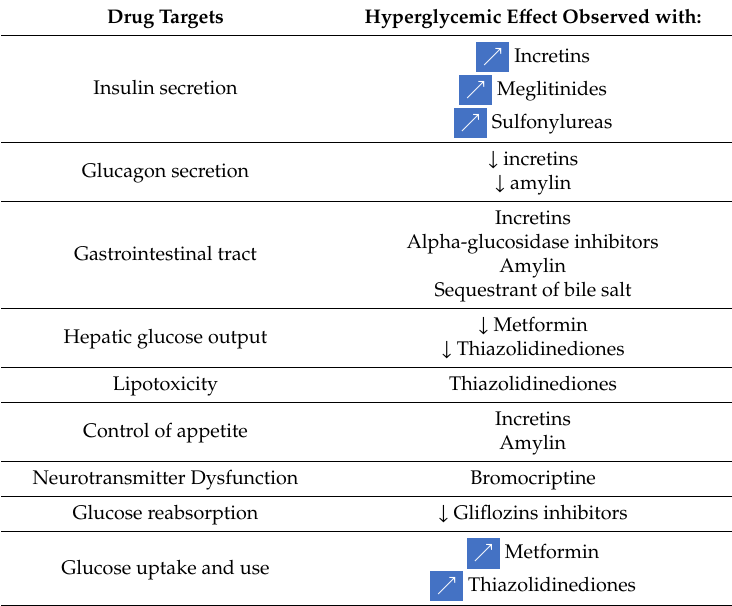
Table 1. Main targets of the hypoglycemic drugs currently approved for the treatment of diabetes mellitus (Adapted from [33]).